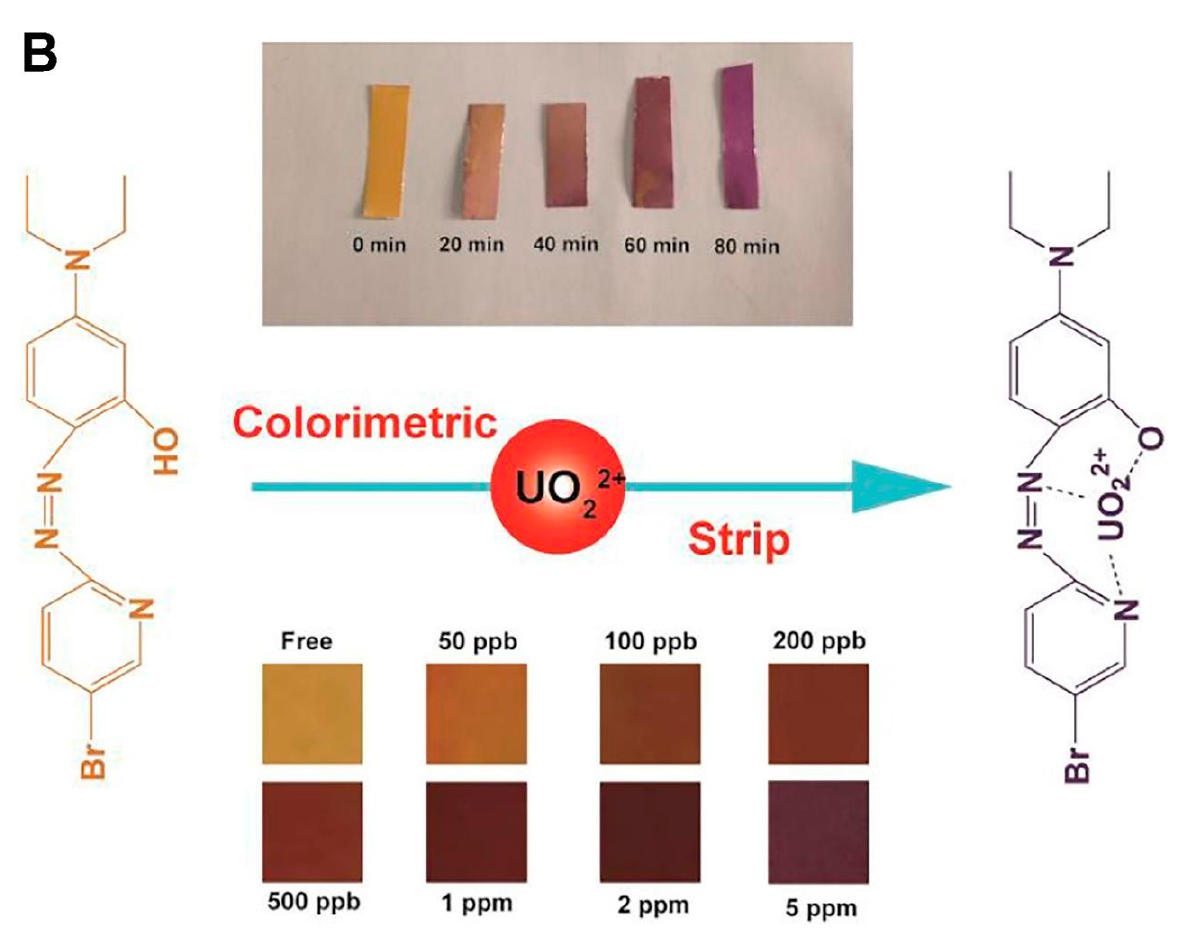
Figure 4. Application of optical detection sensors in environmental pollution. ( A ) ( a ) After adding different metal ions at a concentration of 2000 mg/L, the lignin-based hydrogel exhibited changes in its fluorescent properties. ( b ) The addition of various heavy metals caused the AQY (absolute quantum yield) of FLH-3, a hydrogel made from lignin, to vary. ( c ) The concentration of Cr(VI) had a gradual effect on the fluorescence of FLH-3, resulting in a decrease over time (reproduced with permission from [159], copyright © 2021, Elsevier). ( B ) The process of complex formation with uranyl ions, the duration required for colorimetric detection in photographs, and the optical colorimetric response of Br-PADAP/CA NFs at varying concentrations of UO 22+ (reproduced with permission from [170], copyright © 2017,